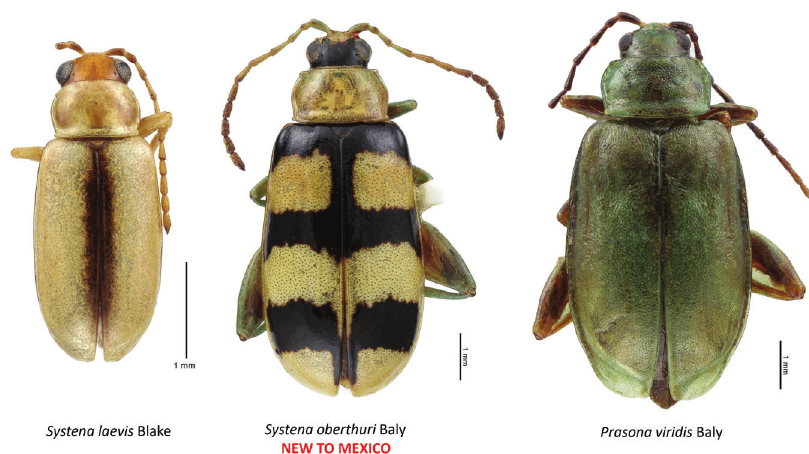
Figure 12. Systena and Prasona generic confusion.